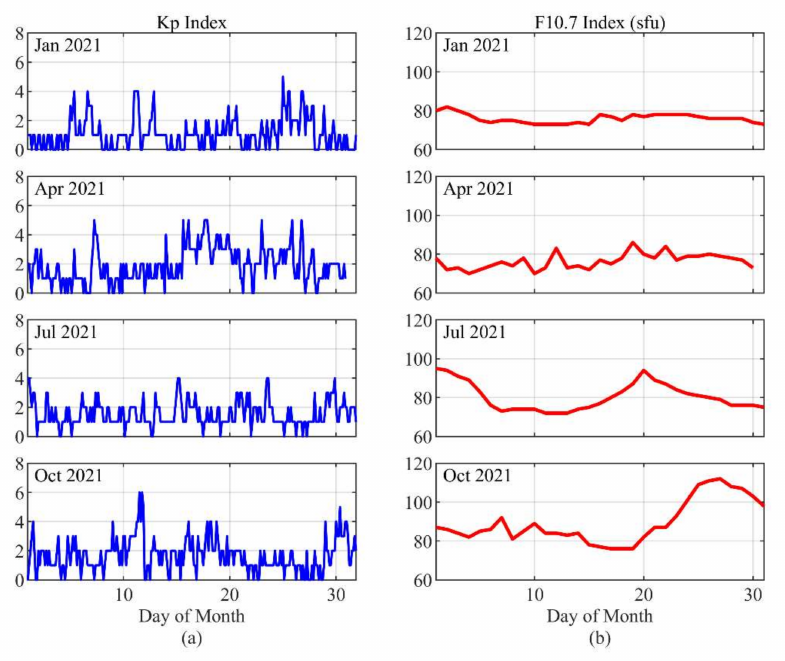
Figure 3. Kp index and F10.7 index for the reference period: ( a ) Kp index; ( b ) F10.7